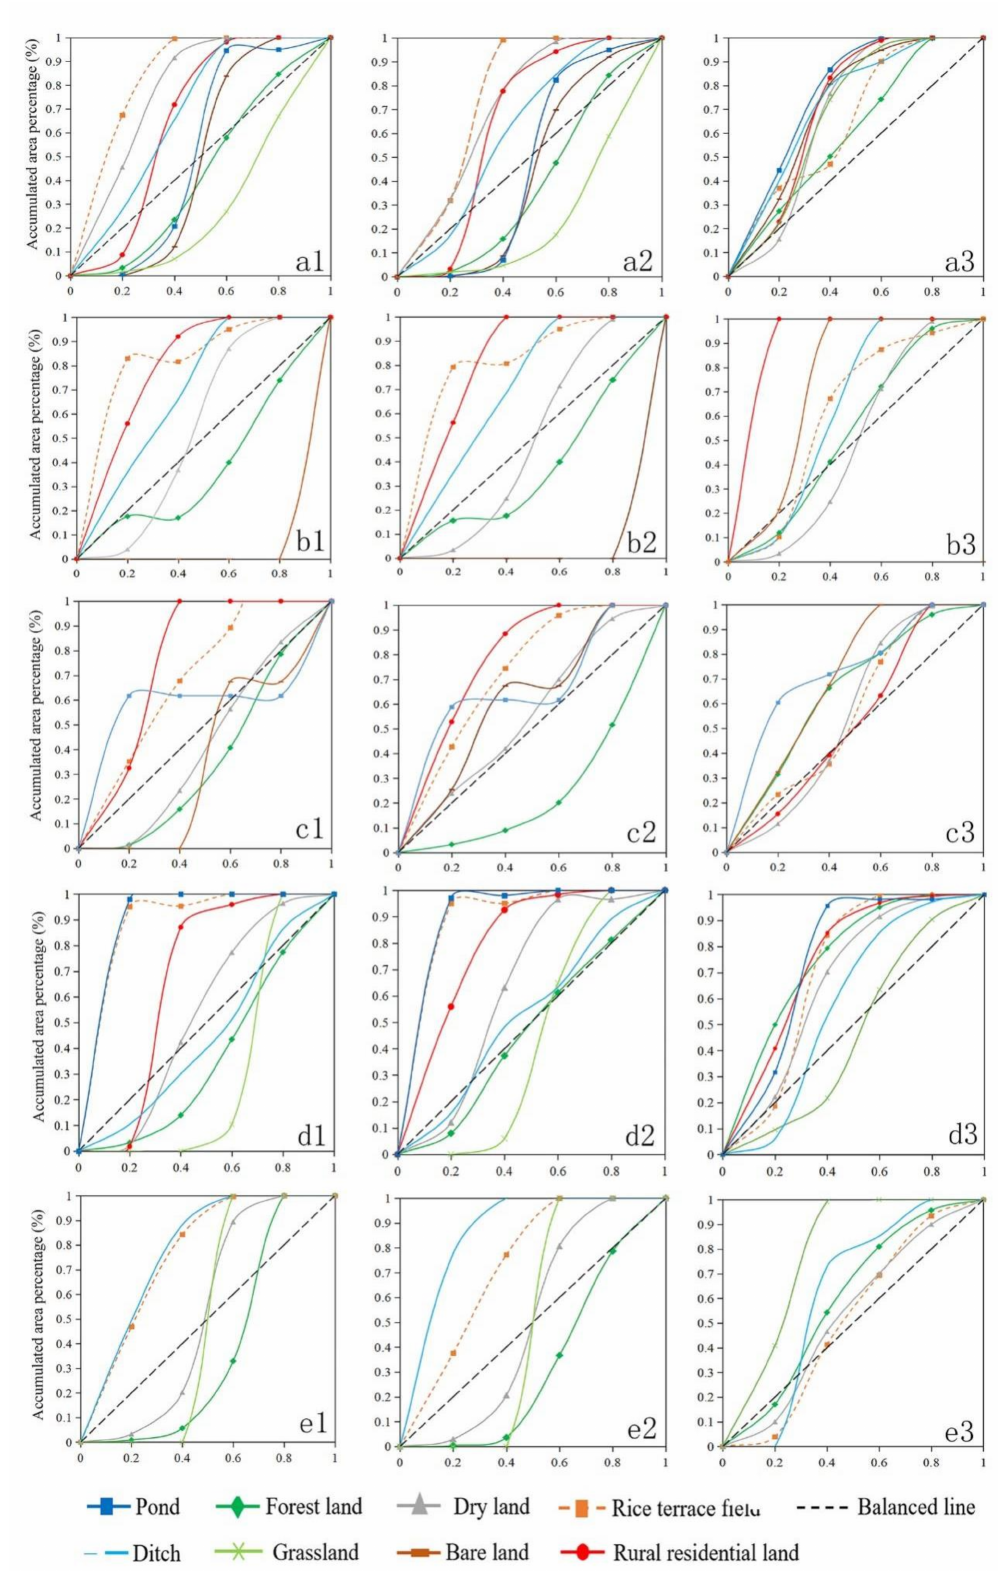
Figure 2. Lorenz curves of landscapes related to relative distance, relative elevation and slope gradient in the five watersheds (( a – e ) indicate the watersheds; ( 1 )—relative distance; ( 2 )—relative elevation; ( 3 )—slope